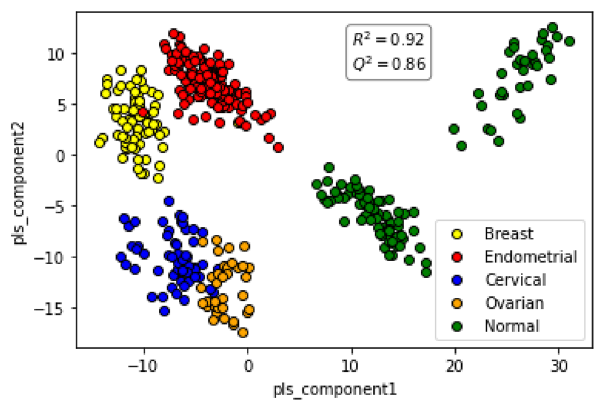
Figure 4. PLSDA plot distinguishes between the individual cancers and also the normal controls. Figure presents a PLSDA plot of the matrix of sample-specific metabolites versus metabolite intensity for normal controls and the individual women-specific cancer sets. The separation obtained between the individual groups is shown. The R 2 and Q 2 values obtained are